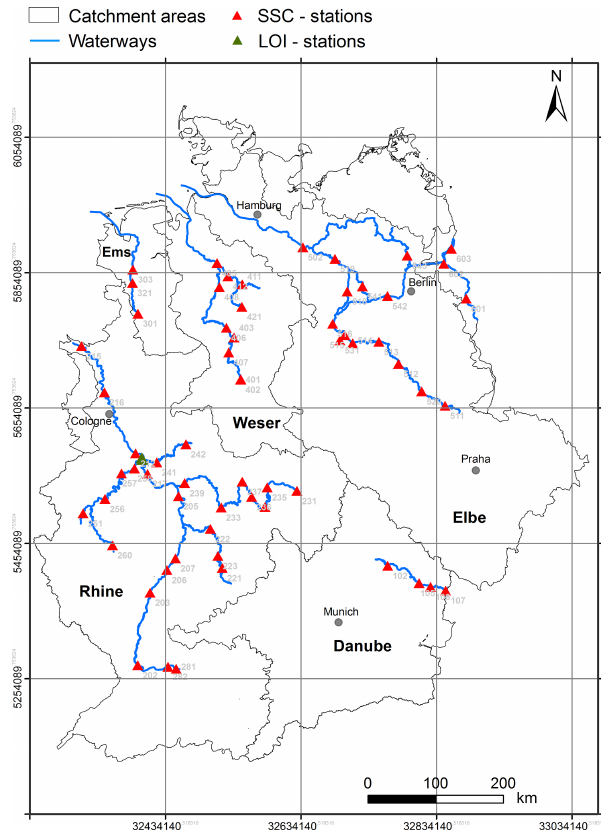
Figure 1. Selected sampling locations of the WSV suspended mon- itoring network used in this study covering the major river basins in Germany as shown. Labels refer to the station codes given in Table 1. Note that the two green triangles of the LOI stations in Koblenz (IDs 998 and 999 in Table 2) overlap due to their proxim-